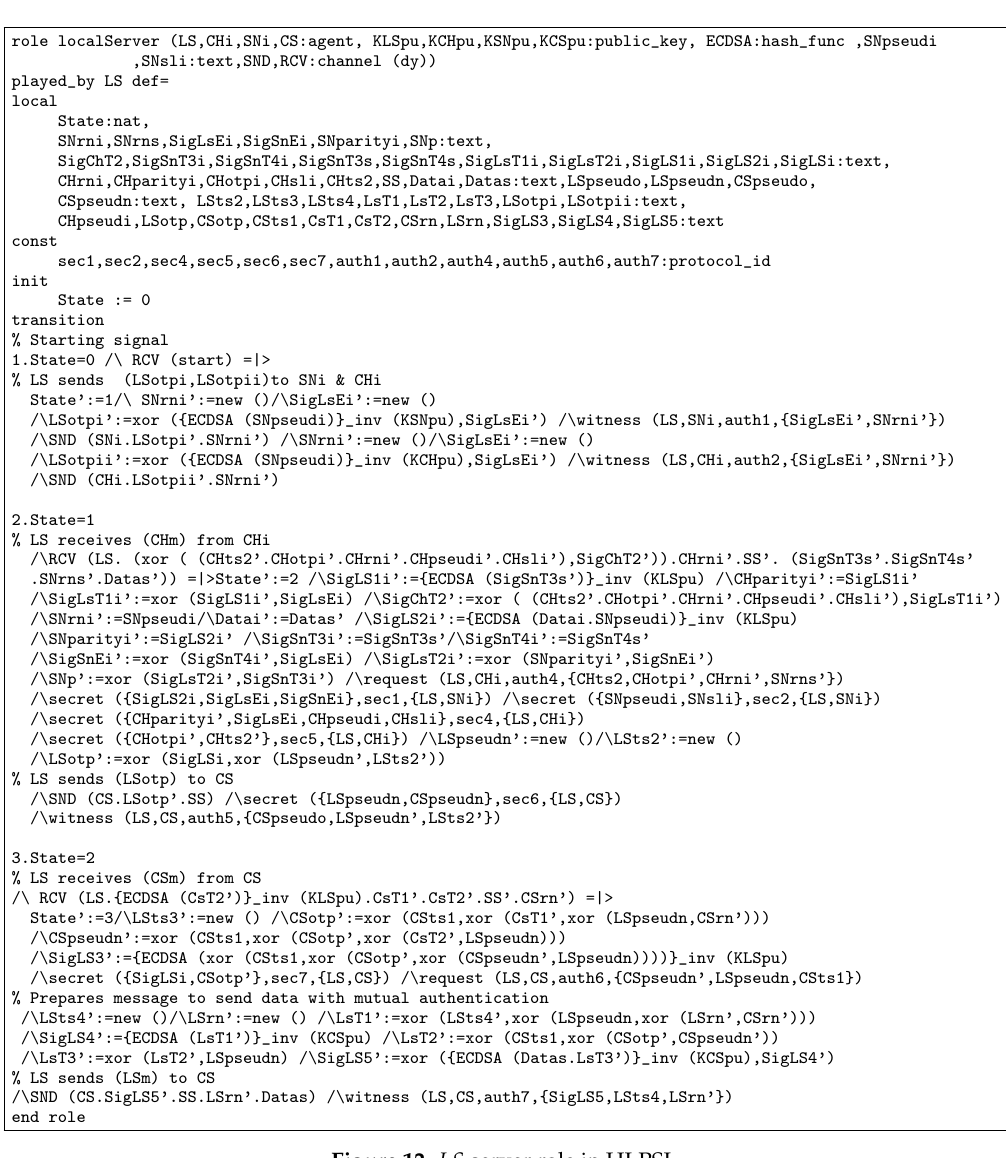
Figure 12. LS server role in